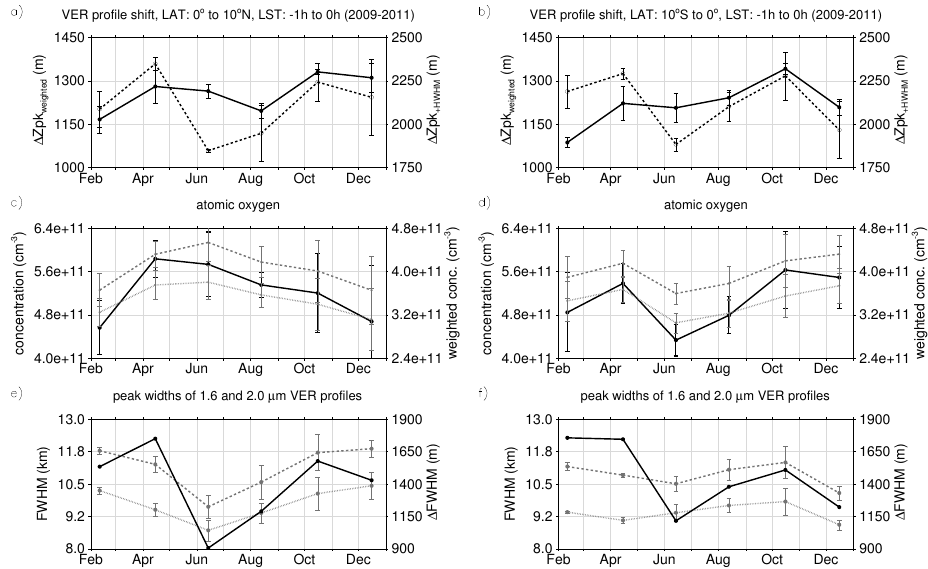
Figure 5. SABER results based on 3 years of observation. Each point represents the mean value of three yaw cycles according to each year, the standard deviation is denoted by the error bars. (a–b) Seasonal variability in the vertical shifts between the 1.6 and 2.0µm VER profiles. Solid line/left axis: Vertical VER profile shifts between weighted peak altitudes according to Eq. (4). Dashed line/right axis: Vertical VER profile shifts between the +HWHM-shifted peak positions according to Eq. (5). (c–d) O concentrations at 90km (left axis, black solid line) and 1.6 as well as 2.0µm VER profile weighted atomic oxygen concentrations (right axis, dotted and dashed grey lines). (e–f) /left axis: Full peak widths of 1.6 and 2.0µm VER profiles (dotted and dashed grey lines). (e–f) /right axis: Relative difference between the full peak widths of the 1.6 and 2.0µm VER profiles (black solid line).